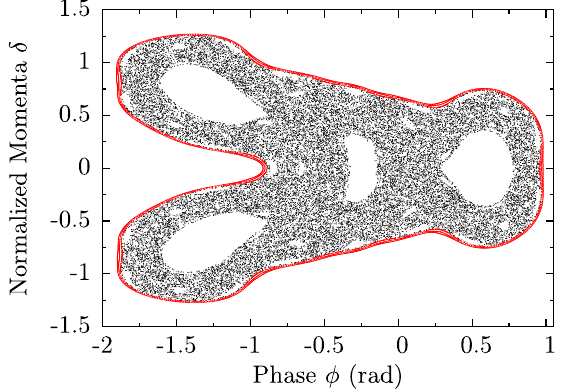
FIG. 7. Nondiffusive Poincaré surface of section with param- ¼ 8 ° and Δ ϕ ¼ 30 °. The initial particle bunch is eters a m o FIG. 8. Poincaré surface of section depicting the diffusion of the confined between the (blue) 5 ∶ 2 and (green) 7 ∶ 3 resonant Gaussian bunch of σ ϕ ¼ 1 × 10 − 3 rad and σ δ ¼ 1 × 10 − 3 initially islands. The (magenta) 8 ∶ 3 resonance can be seen about to at the primary-rf-only phase-space origin after 1.5 million revo- merge with the layers of overlapping (yellow) higher-order ¼ 58 ° and Δ ϕ ¼ 30 °. The red points depict the lutions where a m o resonances surrounding the resonant islands of the (red) 3 ∶ 1 single-particle tracking of test particles placed initially near the resonance. Well-behaved tori bounding the regions of chaotic edge to show that the structure is indeed particle motion are observed. Fig. 8, depict the last five modulation periods after tracking for 1.5 million revolutions where particle diffusion has taken place. The red points depict stable tori bounding the diffused chaotic region. The small bunch at the origin of the primary-rf-only phase space had been driven into the thick chaotic layers surrounding the separatrices of the 3 ∶ 1 resonance. The thick stochastic layers, on the other hand, come from the overlapping of the 5 ∶ 2 , 7 ∶ 3 , 8 ∶ 3 , and possibly many other higher-order resonances. Aside from the four empty spaces corresponding to the four stable fixed-points associated with the 3 ∶ 1 resonance, the result- ing longitudinal distribution of particles in the bunch is nearly uniform. Particle tracking was continued by increas- ing the number of revolutions to be much greater than 1.5 million, to show that the particles filling the large chaotic region remained bounded and no particle loss was